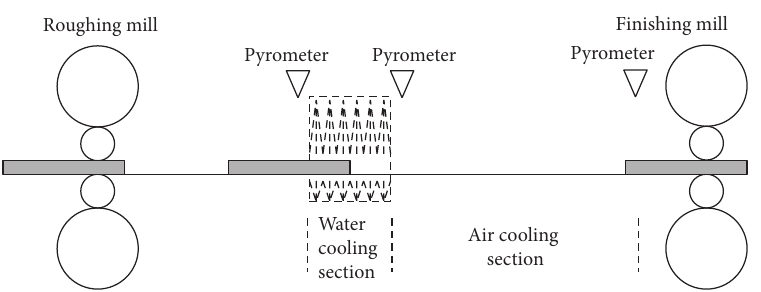
Figure 1: Schematic layout of the production line.